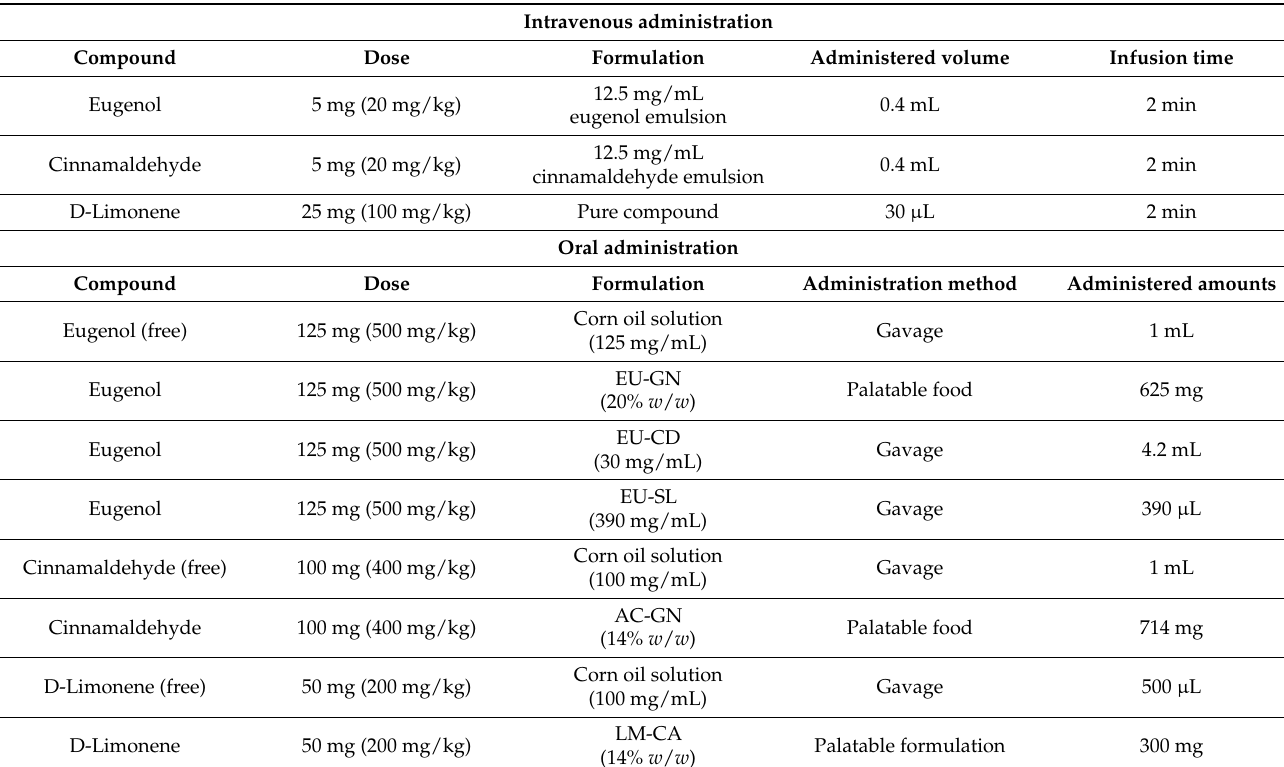
Table 5. Doses and administration modalities to rats of eugenol, cinnamaldehyde and D-limonene by intravenous and oral